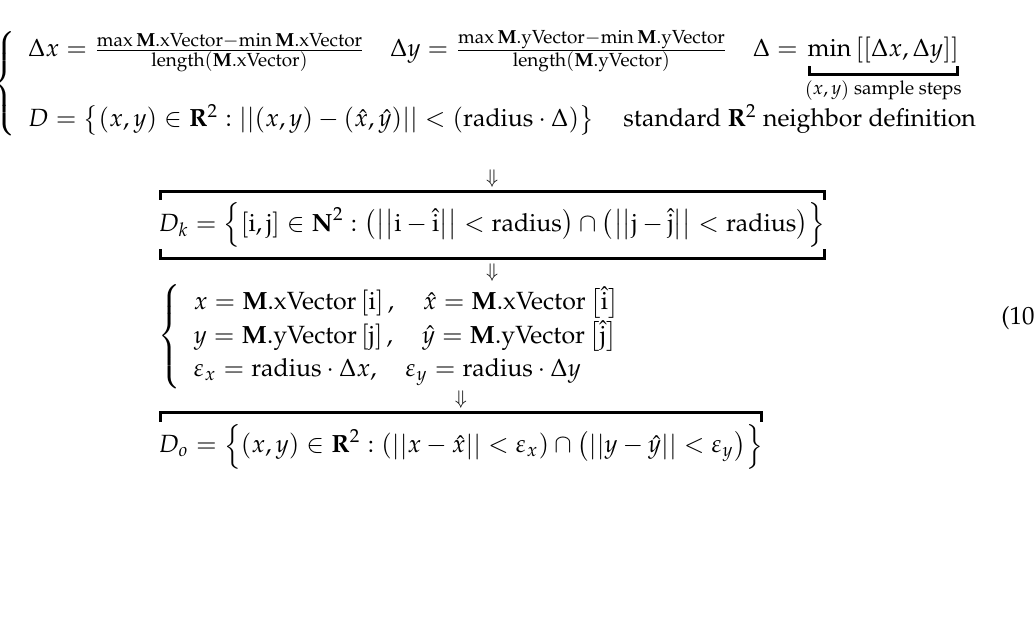
Figure 8. Example of pseudospectrum C ( x , y ) composition using an adaptive masking algorithm. The radius of the point’s neighbour is defined through a proportionality constant number of points over the localization domain’s minor dimension (conventionally k 0 = 0.1); the process for checking for an effective domain is shown